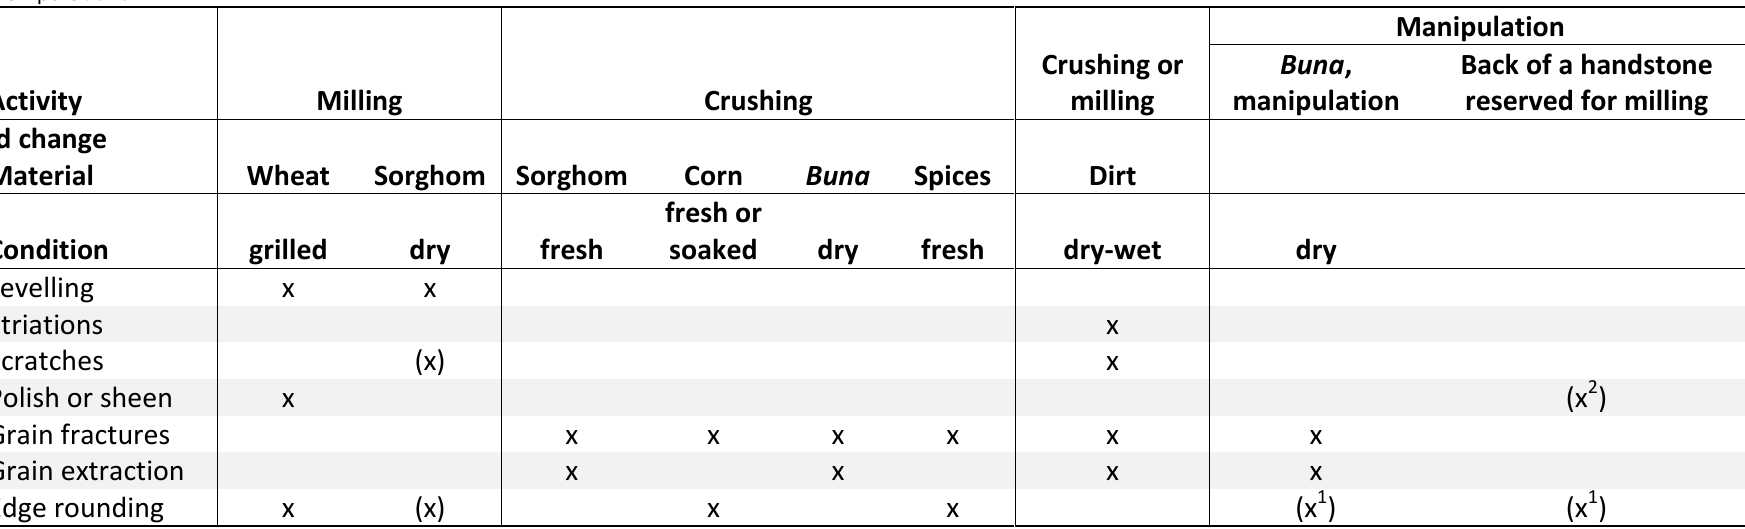
Table 3. Use-wear traces caused on granite querns and handstones depending on the material that is processed and its condition. Abbreviations: x - Stigmas associated with a different used; (x) - Some of this use wear is seen on the active surface (not generalize); (x 1 ) - Leveling of the height topography from manipulation; (x 2 ) - Polish from